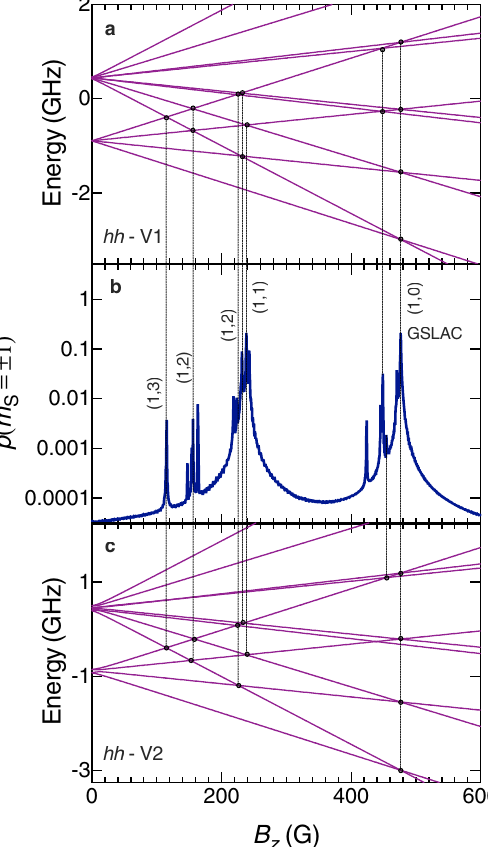
Fig. 5 Identi fi cation of resonance peaks for the hh divacancy interacting with spin-3/2 silicon-vacancy centers. a and c show the energy levels structure of hh divacancy-V1 silicon-vacancy and hh divacancy-V2 silicon-vacancy two spin systems, respectively. b depicts the derived population curve for hh divacancy. At each resonance peak, a pair of numbers in parenthesis provides the jump of the spin quantum numbers of the divacancy and silicon-vacancy centers at the assigned level